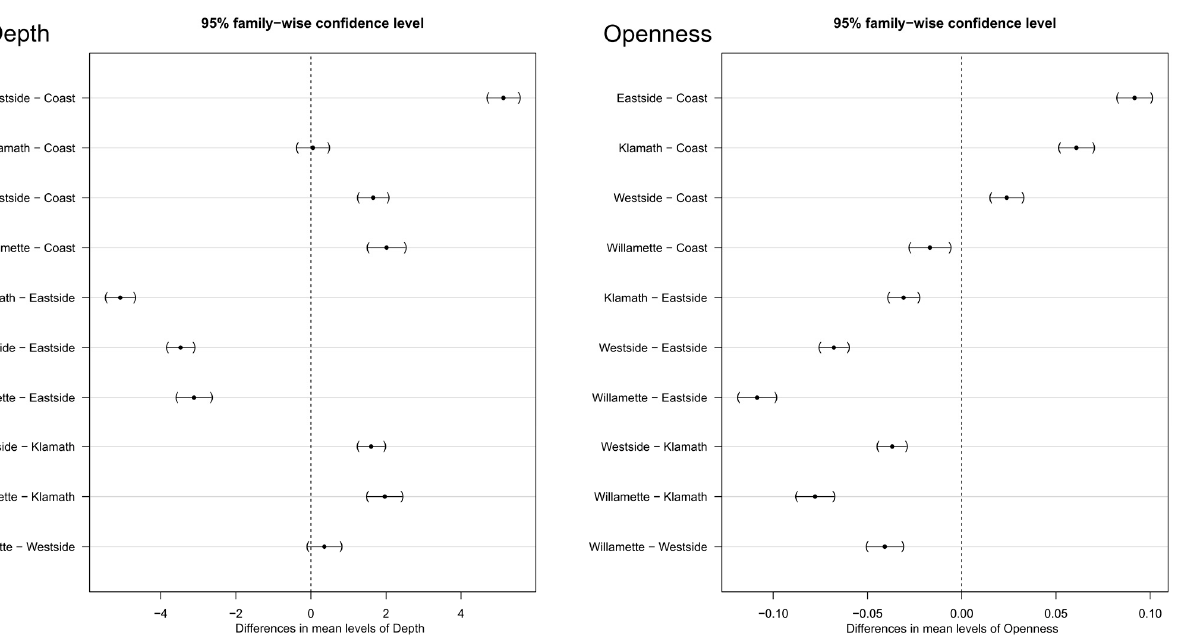
Figure 8. Tukey HSD results for the post hoc ecoregion comparison of both the depth and openness metrics. The closer to the centerline, the more similar the two regions were in their respective metric.